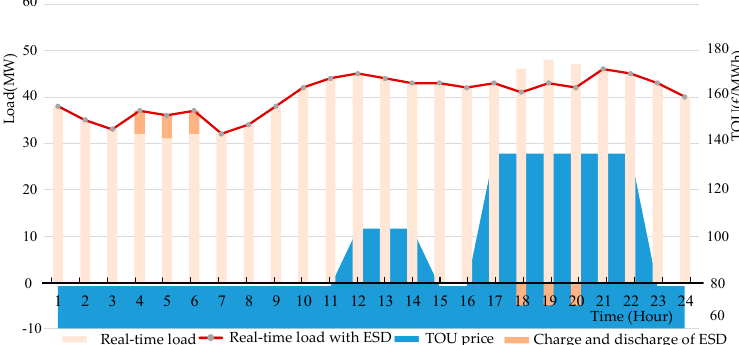
Figure 3. Operation mode of the